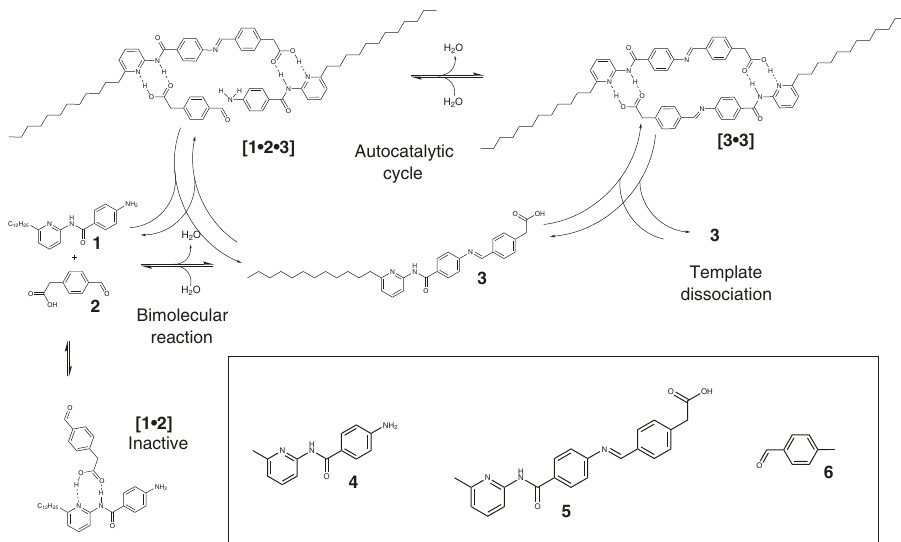
Fig. 2 Chemical structures. Extending on an existing self-replication motif 11 , modi fi ed template replicators were designed to form amphiphilic products, and synthesised according to Supplementary Figs. 1 and 2. Hydrophobic amine 1 contains a dodecyl group as a hydrophobic tail, but is only weakly amphiphilic. It reacts with 4-formyl(phenyl) acetic acid 2 in chloroform, which has a carboxylic acid group as its recognition site that doubles as the surfactant head, to form amphiphilic imine 3 . Amine 4 is the original unmodi fi ed amine, imine 5 is the unmodi fi ed imine, and p -tolualdehyde 6 is used as a control substrate as it lacks a recognition